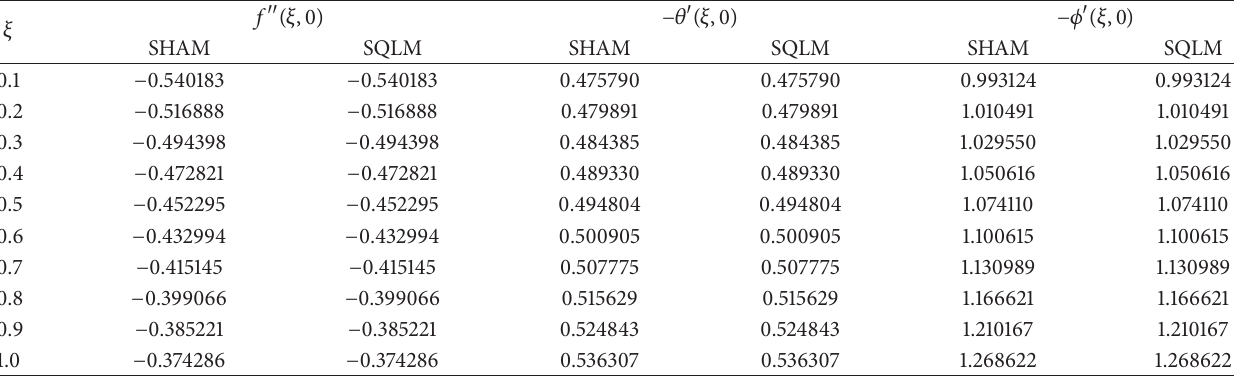
Table 1: Comparison of the SHAM solutions for 𝑓 󸀠󸀠 (𝜉,0) , −𝜃 󸀠 (𝜉,0) , and −𝜙 󸀠 (𝜉, 0) against those of the SQLM at different values of 𝜉 . 𝑀 = 𝐾 = 30 , ℎ = − 1, 𝐿 = 30 , 𝑁 = 100 , 𝜆 = 0.5 , Pr = 0.7 , Nr = 0.5 , Le = 3 , Sc = 1 , 𝛼 = 1 , and 𝜎 = 1